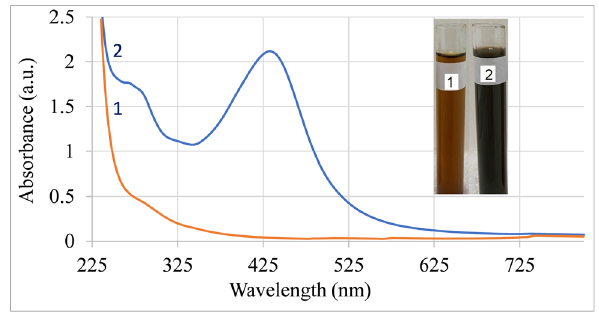
Figure 1: UV - Vis spectrum of extract ( 1 ) and AgNPs@Org ( 2 ) . ( Inset ) The solution of extract ( 1 ) and AgNPs ( 2 ) .